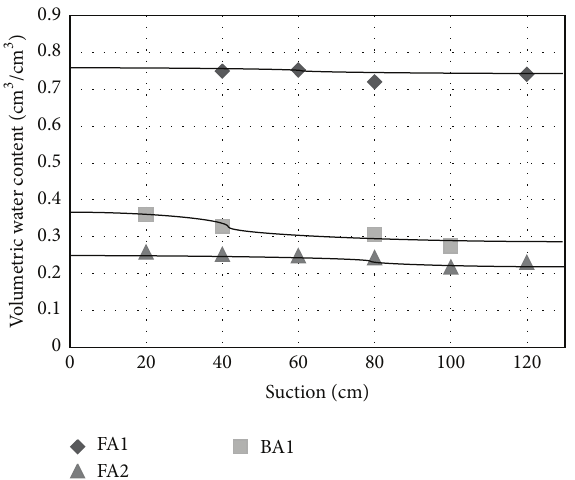
Figure 4: Water retention characteristics of the coal ash: curve approximation was drawn by the Van Genuchten model.